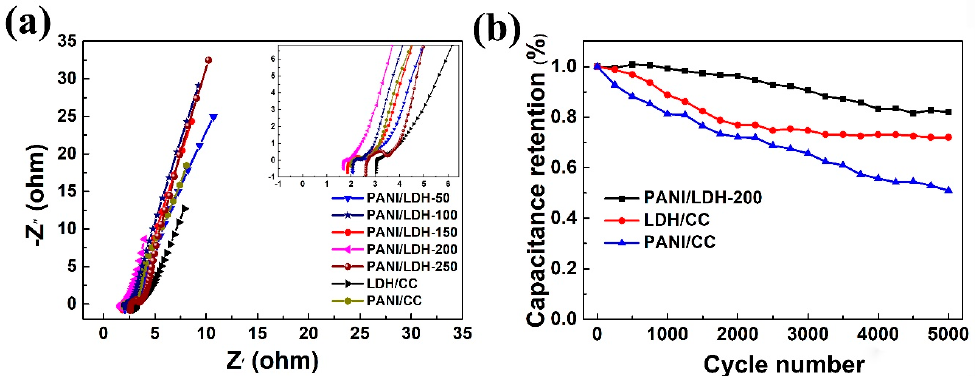
Figure 6. ( a ) Nyquist plots of LDH/CC, PANI/CC and PANI/LDH-T (T = 50, 100, 150, 200, 250), the inset indicates the enlarged Nyquist plots at high-frequency region; ( b ) cycling stability of the LDH/CC, PANI/CC and PANI/LDH-200.